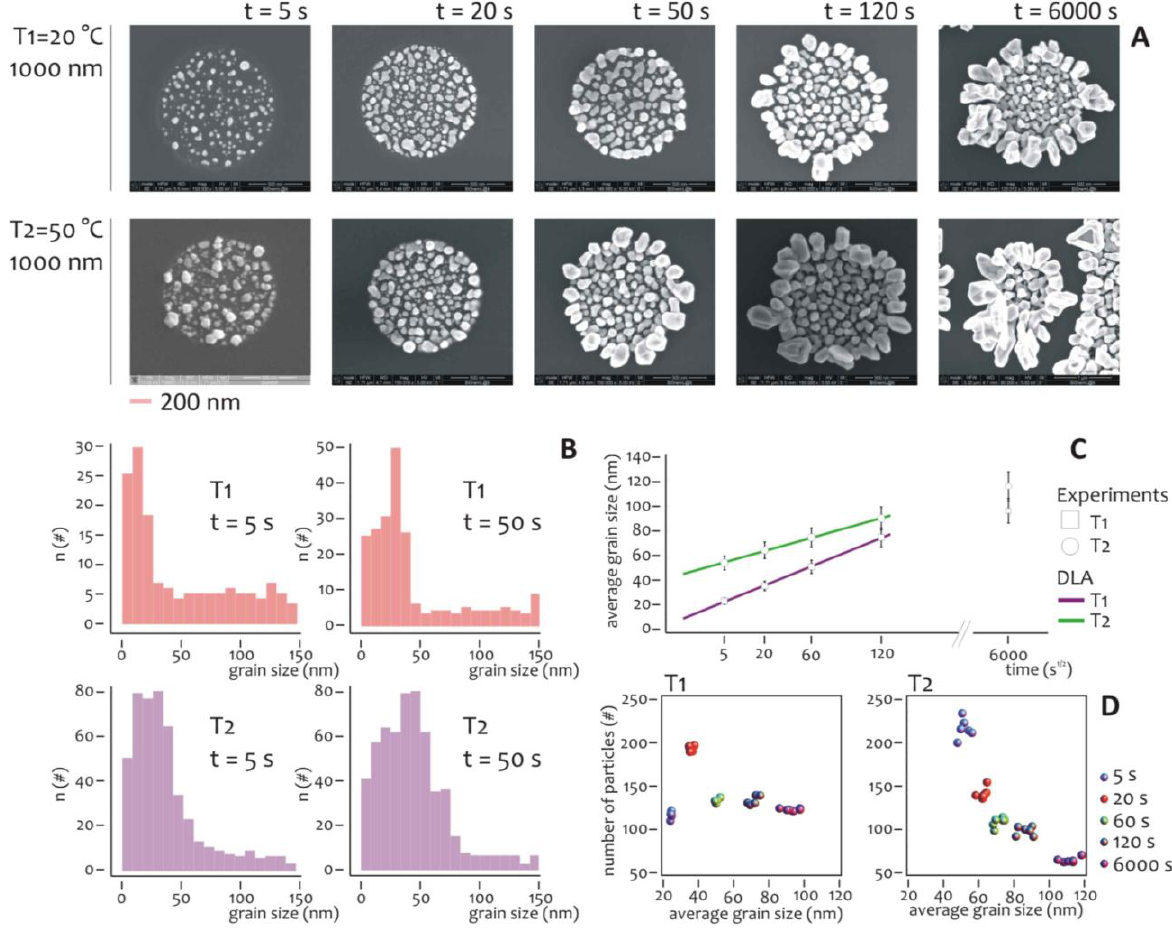
Figure 3. The effect of temperature and time of deposition on the characteristics of the aggregates of nano-particles. In ( A ), the SEM micrographs of the nano-particles aggregate, taken at low T1 = 20 °C and high T2 = 50 °C temperature, reveal the evolution of the growth front of silver with time (A). The cited SEM images can be conveniently processed and used to extract quantitative information of the clusters morphology. The average grain size distribution is reported in ( B ) for the limiting cases T1 = 20 °C, T2 = 50 °C, and for the time steps t = (5, 50) s. Complementary to this, the diagram in ( C ) reports the average grain size as a function of the square root of time, where a linear dependence between those variables is revealed, and this is consistent with the growth of particles in a diffusive regime. In ( D ), a scatter plot shows the number of particles as a function of particles size, for the time of the process of deposition varying between 5 and 6,000 s, for the fixed temperatures T = (20 °C, 50 °C). Incidentally notice how, at high temperature, the system is more sensitive to time, than at low